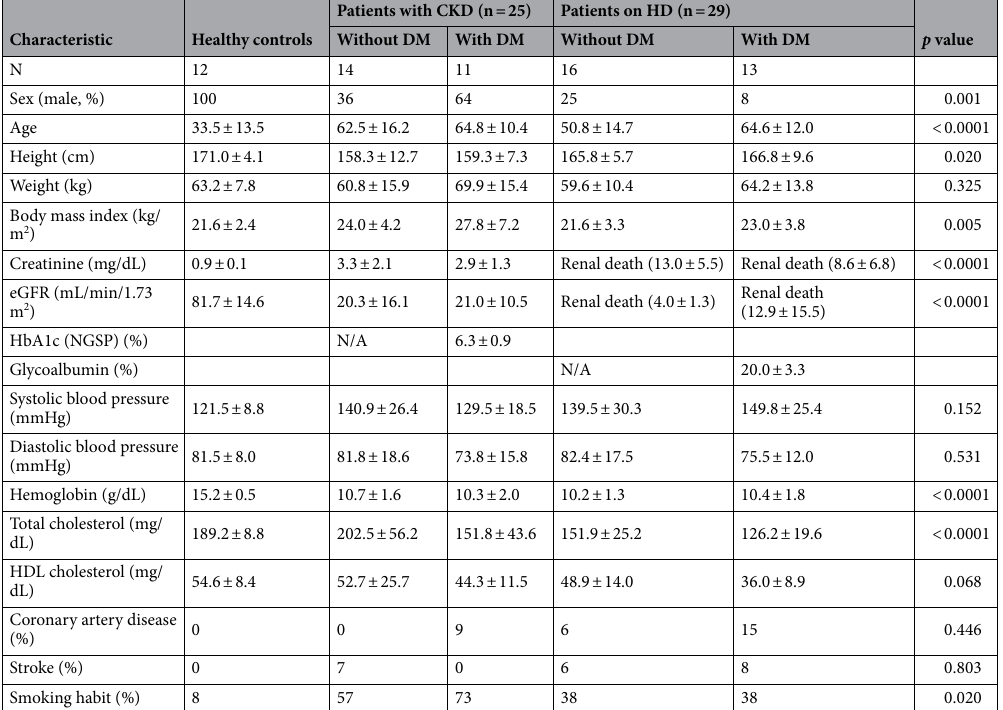
Table 1. Clinical characteristics of the study participants. Values are presented as the mean ± SD or %. CKD chronic kidney disease, DM diabetes mellitus, eGFR estimated glomerular filtration rate, HD hemodialysis, HDL high-density lipoprotein, N/A not